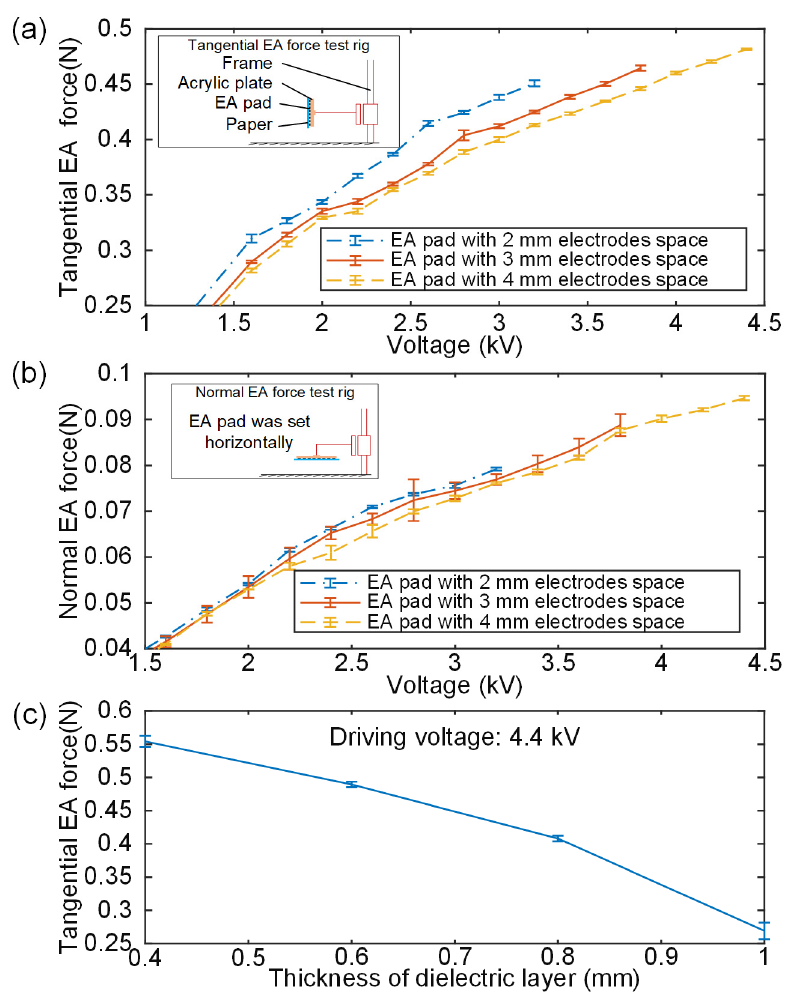
Figure 5. EA pad geometric parameter selection test: ( a ) tangential force test results. Inset shows the schematic diagram of the tangential EA force tests and ( b ) normal EA force test results. Inset shows the schematic diagram of the normal EA force tests and ( c ) tests of tangential EA force on four EA pads with varying dielectric layer thicknesses.